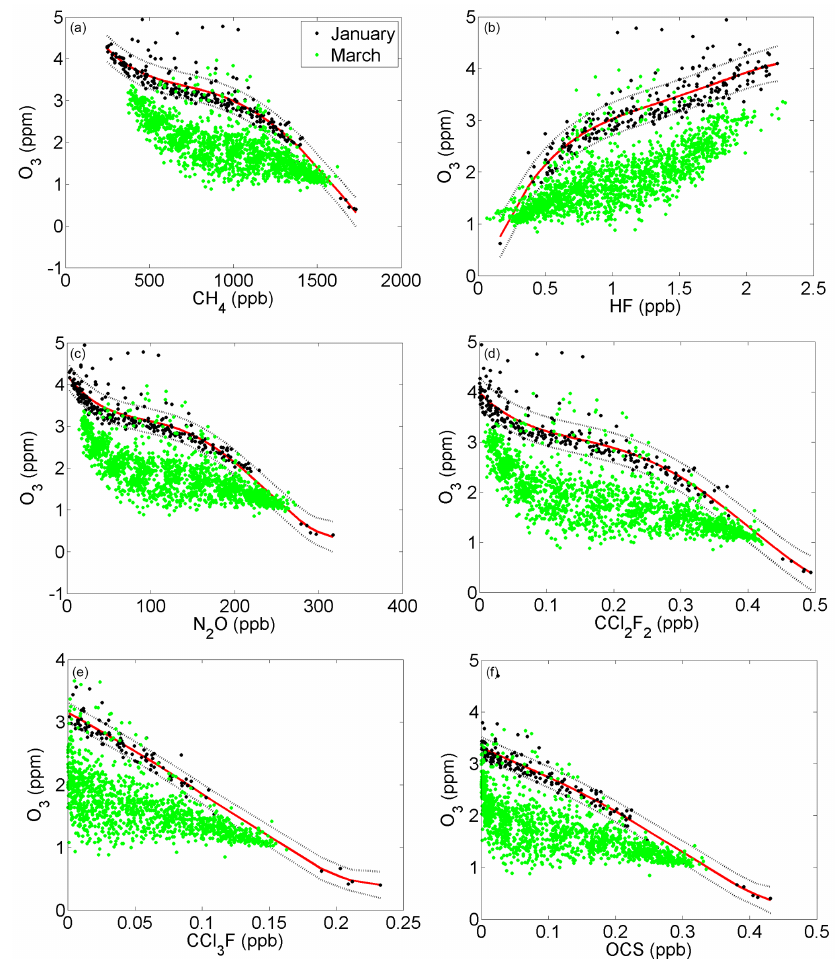
Figure 1. O 3 -tracer correlation using ACE-FTS measurements inside the polar vortex in January (black dots) and March (green dots) 2011 using (a) CH 4 , (b) HF, (c) N 2 O, (d) CCl 2 F 2 , (e) CCl 3 F, and (f) OCS as a tracer, in units of volume mixing ratios. The red line shows the estimated early vortex reference function (see text for details) and the dashed black lines indicate the ± 1 σ standard deviation of the